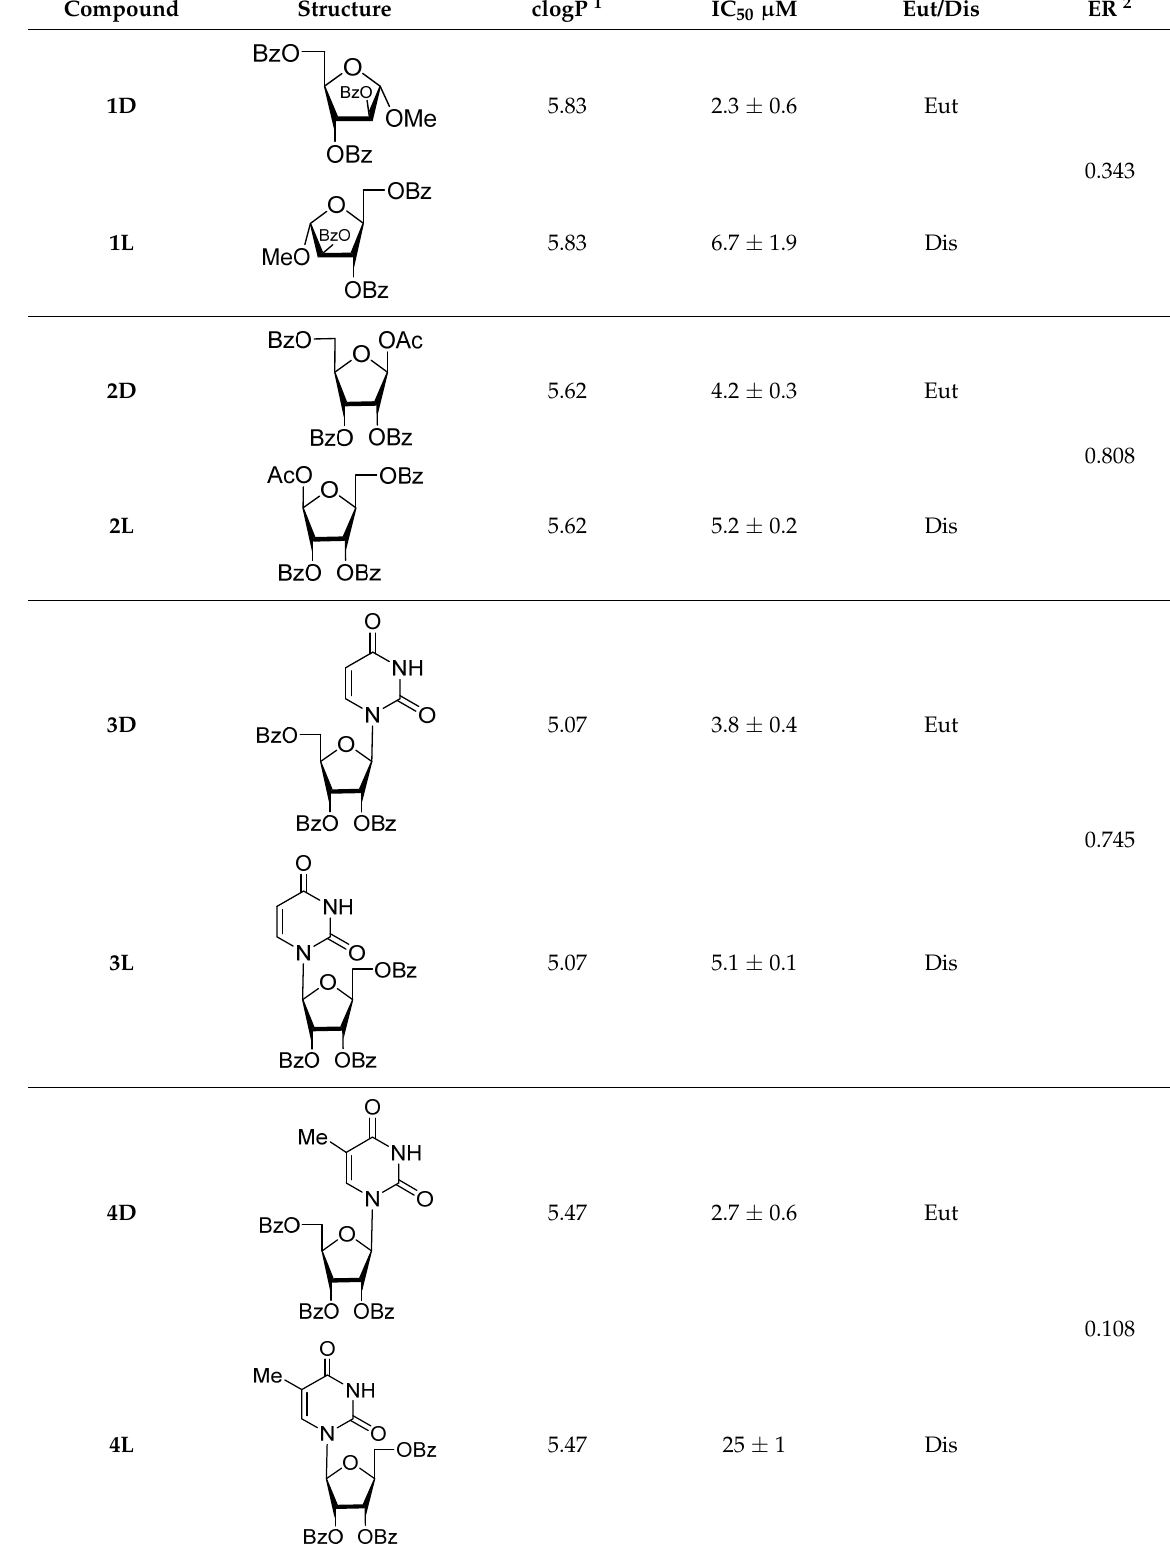
Table 1. Inhibition of Tdp-1 by chiral nucleoside derivatives.